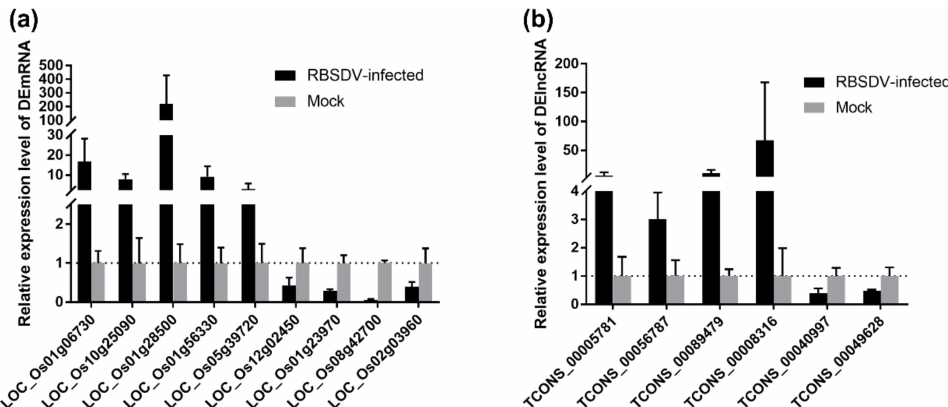
Figure 7. Validation of expression of selected DEmRNAs ( a ) and DElncRNAs ( b ) though qRT-PCR. The total RNA from RBSDV-infected and mock rice plants was extracted for qRT-PCR analyses at 30 dpi. OsUBC gene served as an internal reference for the relative quantification. The values represented means of the gene expression levels ± standard deviations (SD) relative to the mock plants ( n = 3 biological